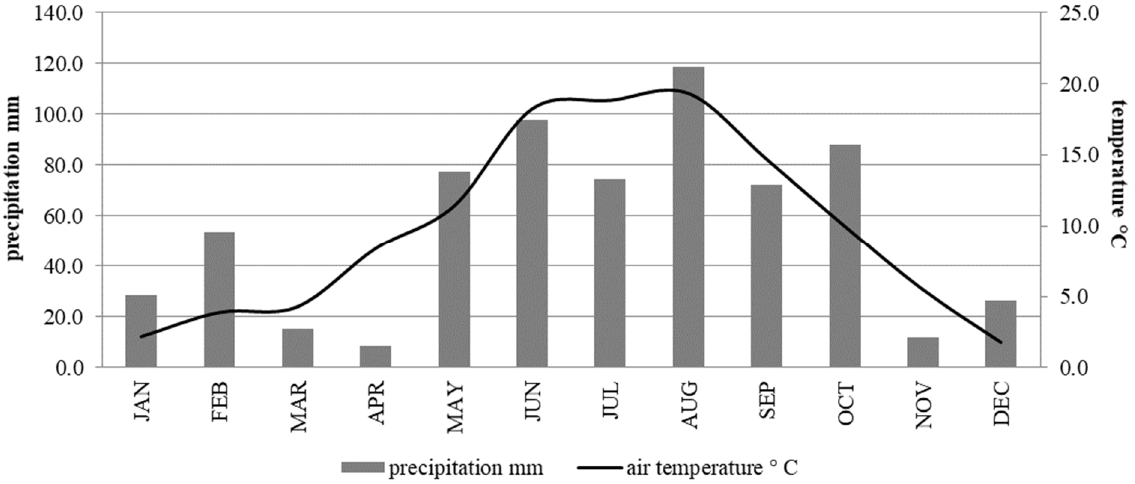
Figure 1. Monthly precipitation totals and temperature in 2020